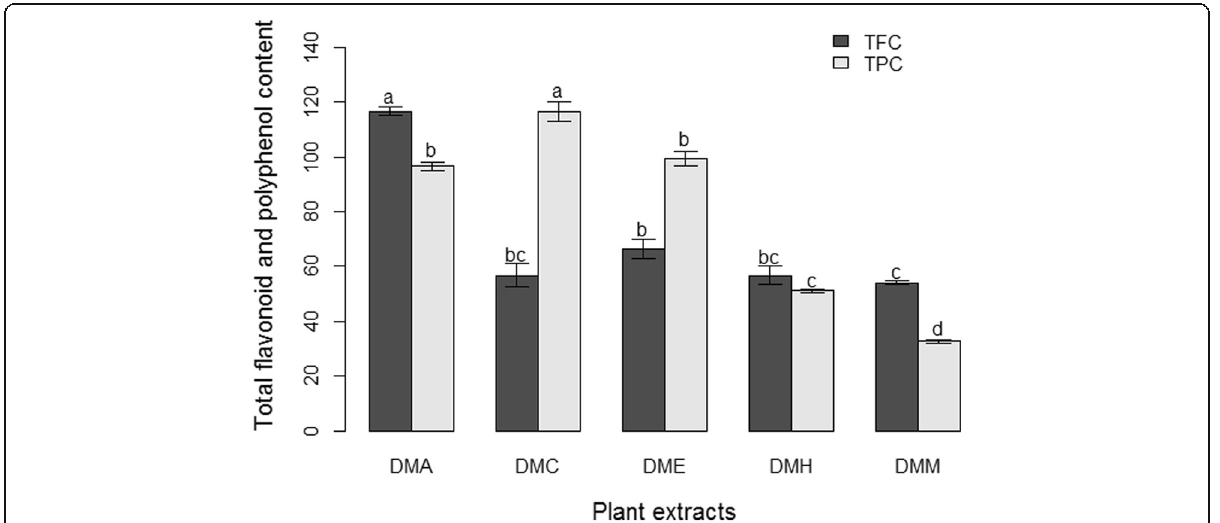
Fig. 1 Total polyphenol and flavonoid contents in crude extracts of D. moniliforme ( n = 3; p ≤ 0.05; values of the same letters are not statistically different)